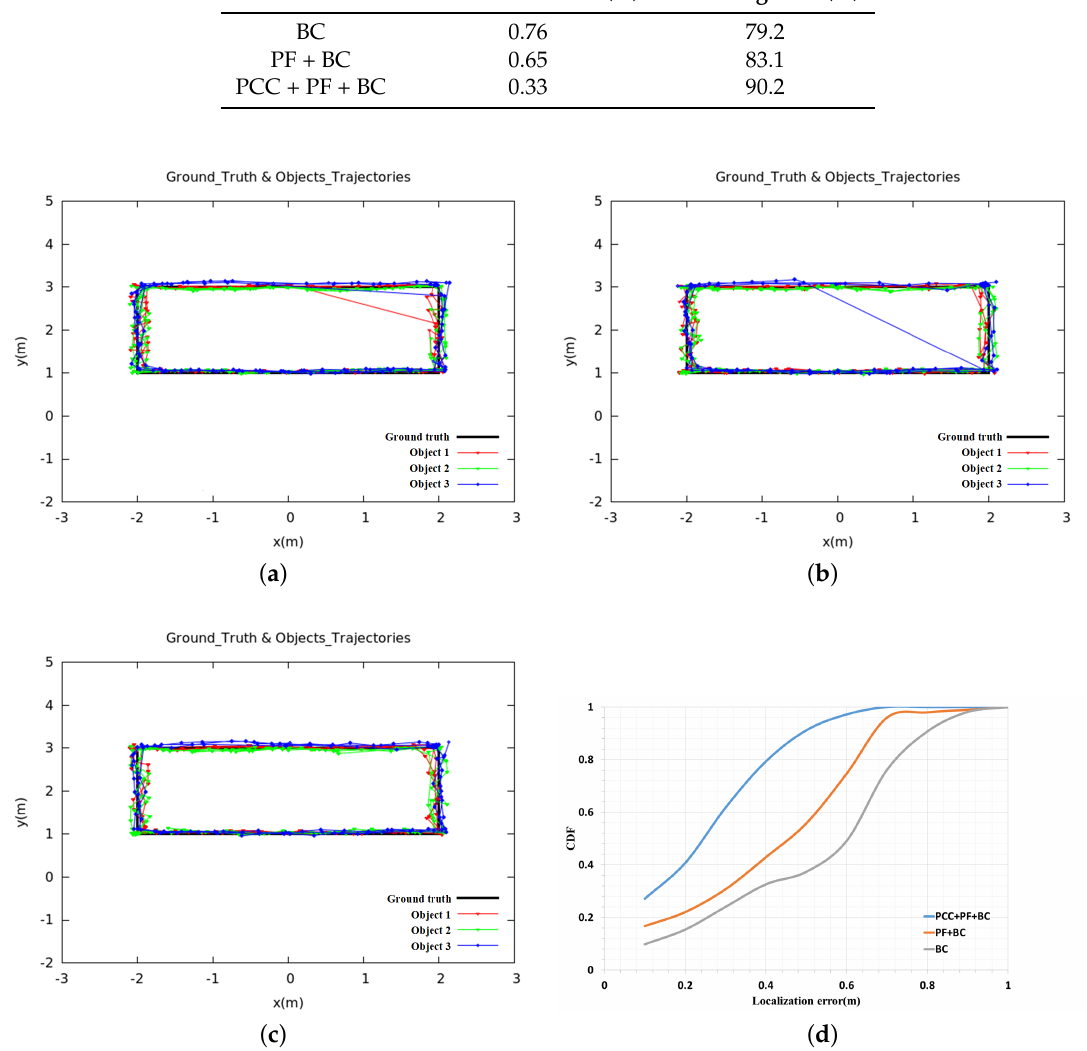
Figure 4. Comparision of the estimated trajectories based on different approaches. ( a ) BC; ( b ) PF + BC; ( c ) PCC + PF + BC; ( d )